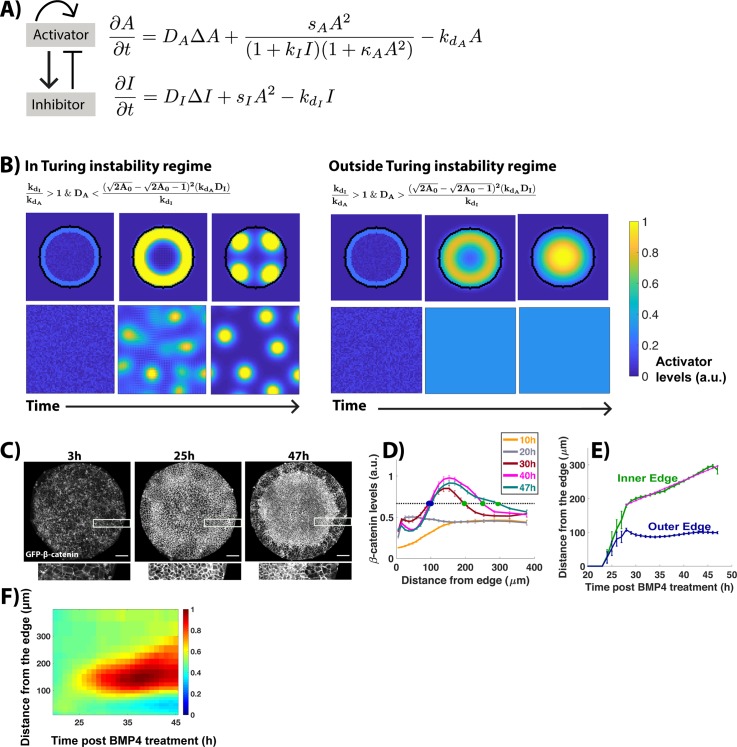
WNT signaling dynamics lie outside the Turing instability regime.(A) Schematic and equations of the model. (B) Evolution of activator levels from the initial state to the steady state. Inequalities define parameter regimes that display each of the 2 behaviors (S1 Model). In each case, the top row shows the model simulated on a circular colony, while the bottom shows it simulated in a domain with cells throughout. Simulation parameters: sA = 0.01, kI = 1, kA = 0, kdA = 0.001, DI = 0.4, sI = 0.01, kdI = 0.008. (left) DA = 0.014, (right) DA = 0.0025 for outside and inside Turing instability regime, respectively. Simulation domain: 190 × 190 pixel square lattice with periodic boundary conditions and random distribution of activator/inhibitor as initial conditions. To simulate the model in circular colonies, a circle (radius: 25 pixels) is defined at the center of the lattice. Outside the circle, sA = sI = 0, and kd = 0.01. (C) Snapshots of GFP-β-catenin hESCs from time-lapse imaging at indicated time points post BMP treatment. Marked regions are magnified in images shown below. (D) Average nonmembrane β-catenin intensity levels as a function of distance from the colony edge. The legend indicates the time post BMP treatment represented by each curve. Green and blue dots represent the front and back edges of the active signaling domain, respectively. (E) The positions of the inner and outer edge of the signaling domain as a function of time post BMP addition. Magenta line shows linear fit with equation 6.02 μm/h × t + 13.57 μm, R2 = 0.98. (F) Kymograph showing spatiotemporal evolution of nonmembrane β-catenin levels. At time points earlier than the first time plotted in D, signaling is below threshold signaling at all positions in the colony. Scale bar = 100 μm. Underlying data can be found in S3 Data. BMP; Bone Morphogenic Protein; GFP; Green Fluorescent Protein; hESC, human embryonic stem cell.